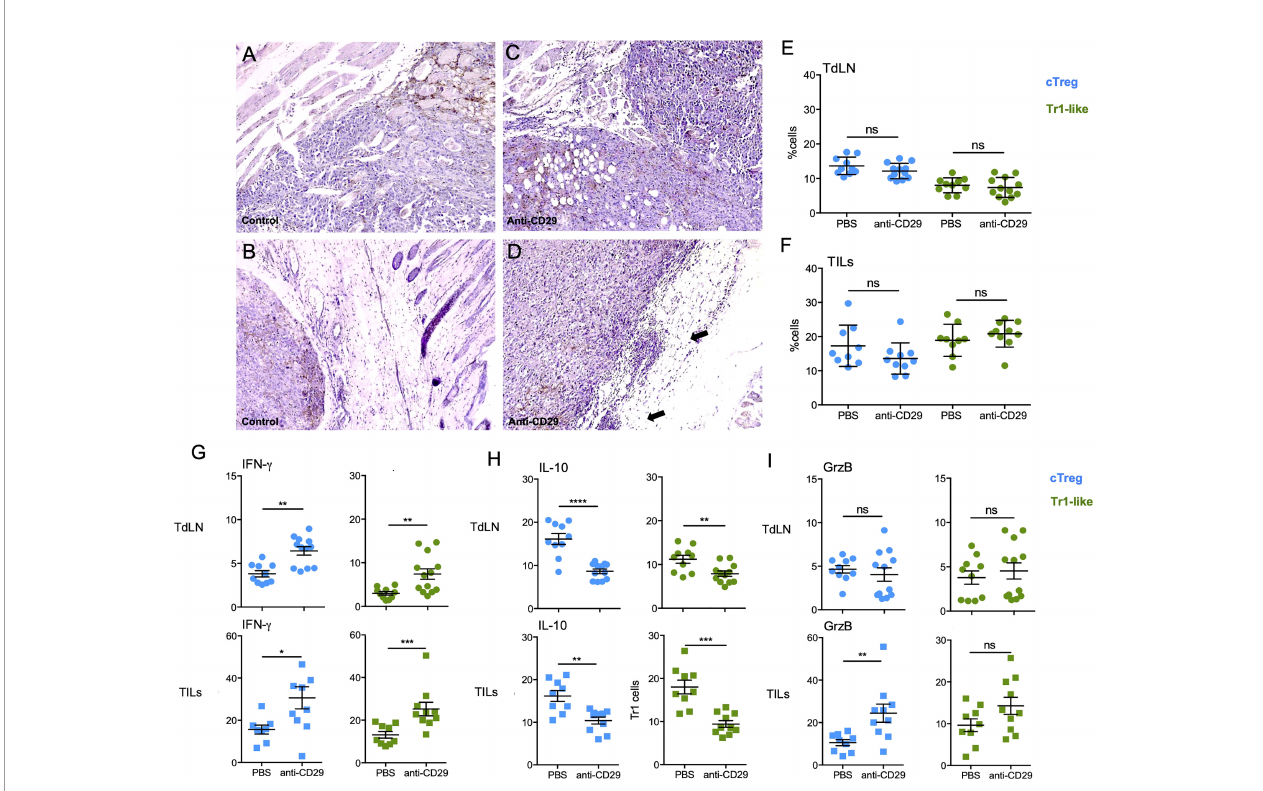
FIGURE 5 | Administration of anti-CD29 antibody changes cTreg and Tr1 cells phenotype favoring a pro-in fl ammatory signature. A total of 2 × 10 5 B16 were injected into the right fl ank of C57BL6 GFP reporter mice. One hundred microliters of PBS 1× containing 200 ng of anti-CD29 antibody, or PBS alone as control, was administered to tumor-bearing animals when the tumors became palpable (approximately day 9 post-tumor inoculation). The treatment was given three times per week. At this time point, animals were euthanized for the isolation of TdLNs and tumors. Tumors were processed for H&E staining, and cell suspensions were processed for antibody staining using anti-CD4, anti-CD49b, anti-IFN- g , anti-IL-10, and anti-granzyme B (GrzB). Panels (A, B) correspond to tumors from control mice and panels (C, D) to tumors from anti-CD29 treated animals at 100×. (E, F) Graphs depicting the frequencies of cTreg and Tr1 cells in tumor-draining lymph nodes (TdLNs) and (F) tumor-in fi ltrating lymphocytes (TILs). Panels (G – I) show the frequencies of both cell populations expressing IFN- g (E) , IL-10 (F) , or GrzB (G) in the indicated tissues and conditions. Data from two independent experiments are shown as the mean ± SEM. n = 5 – 6 mice per experiment. * p < 0.05; ** p< 0.01; *** p < 0.001; ns, not signi fi cant according to Mann – Whitney